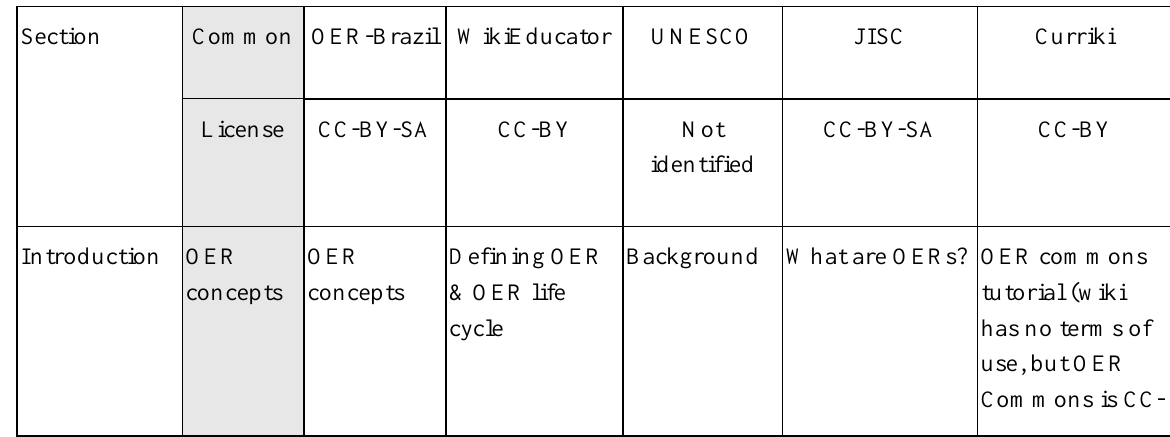
Identification of Common Themes in OER